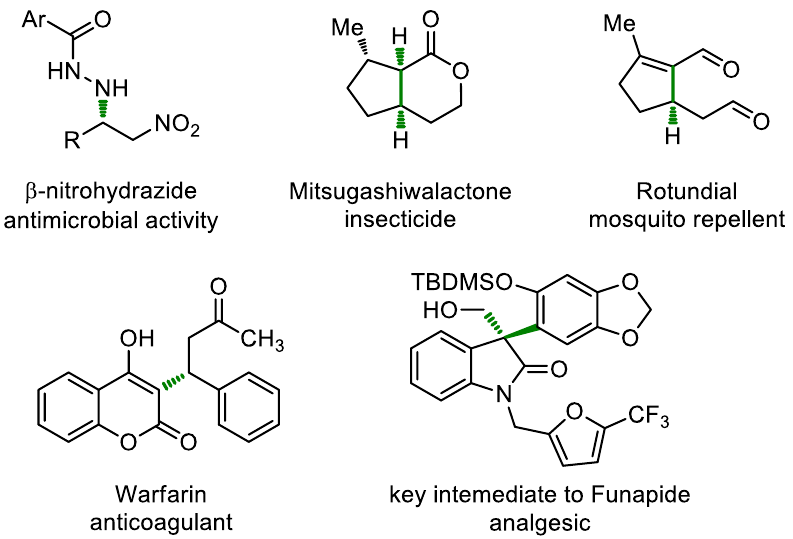
Figure 3. Biologically active compounds synthesized by our group using organocatalytic approaches. The bond formed during the organocatalytic step is highlighted in green.